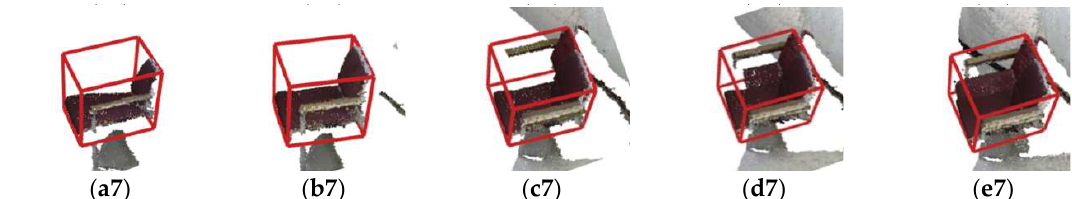
Figure 7. One example of 3D object detection on the SceneNN dataset(sequence ID: 011, ( a1 – e1 ) are the